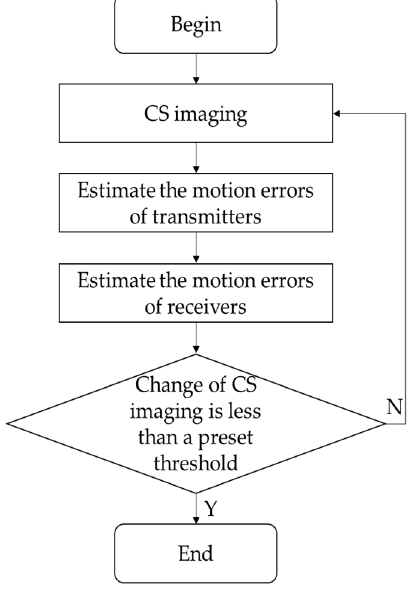
Figure 2. Flow chart of Algorithm 1.